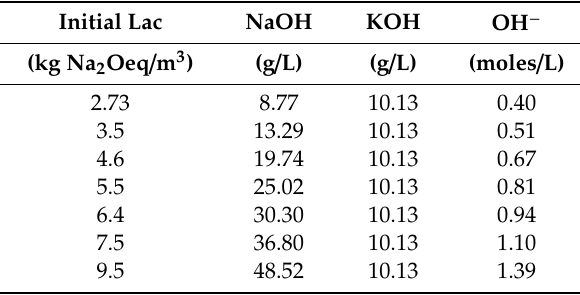
Table 3. Concrete alkali contents and corresponding chemical compositions of alkaline solutions used in the accelerated concrete prism test (accelerated CPT). Initial Lac NaOH KOH OH − (kg Na 2 Oeq / m 3 ) (g / L) (g /